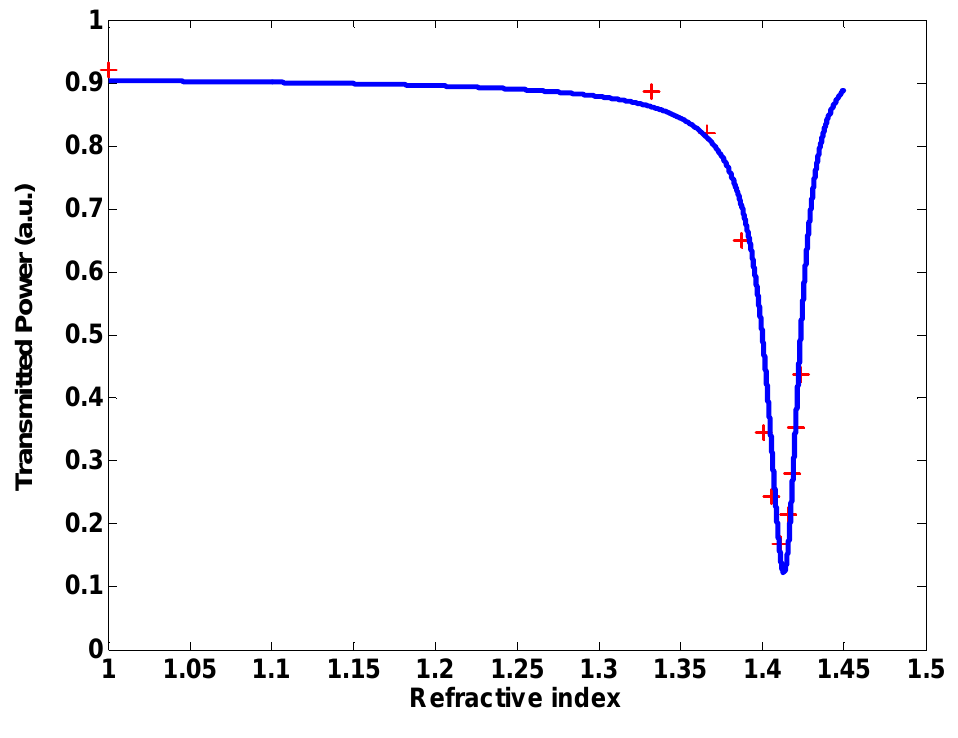
Figure 8. Normalized transmitted power (P/P glycerol) + points measured values; continuous line theoretical fitting.